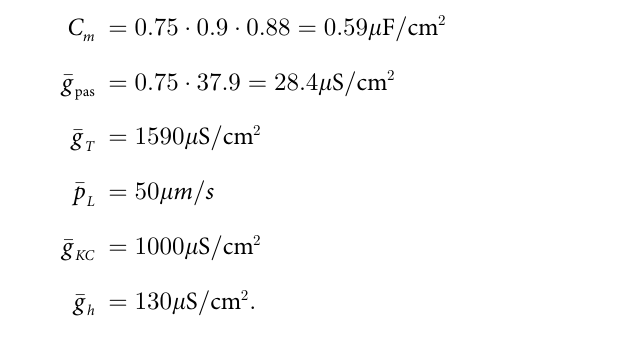
where most events consist of isolated single spikes, as discussed before in section